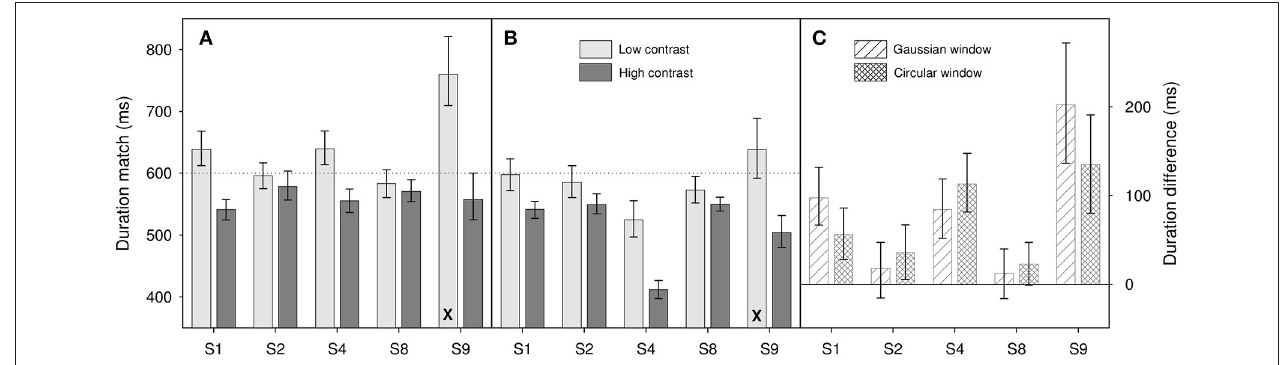
FIGURE 3 | Results from Experiment 1 for (A) Gaussian windowed stimuli, (B) circular windowed stimuli, (C) duration differences for both. Light gray bars show duration matches for the low contrast (0.1) stimuli, dark gray bars show matches for high contrast (0.9) stimuli. (A,B) are shown on the same ordinate scale. Diagonally hatched bars show duration differences for Gaussian windowed stimuli, cross-hatched bars show duration differences for the circular windowed stimuli. Differences are calculated as D low – D high where D low is the low contrast duration match and D high is the high contrast match. Note that the X at the bottom of a bar shows that one psychometric function has been dropped from the analysis (see text for details), those bars therefore show the average of 3 functions, rather than 4. Error bars show 95% confidence limits.